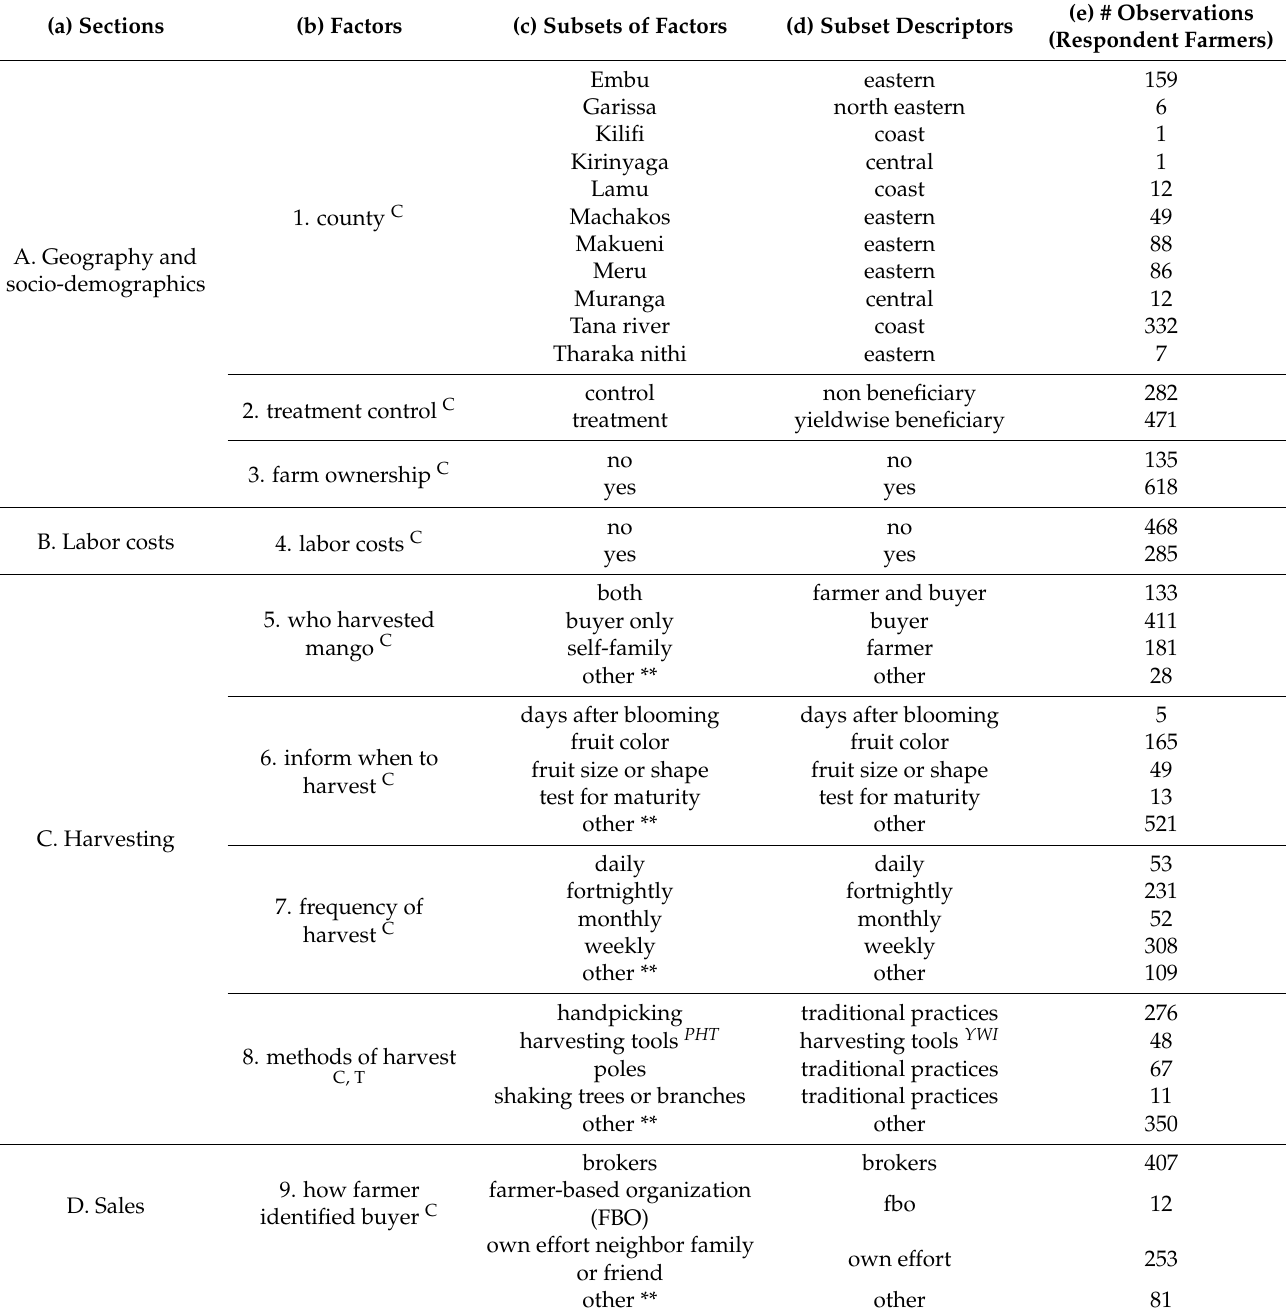
Table 1. A summary of the dataset showing sections, factors, subsets of factors, and respondent farmers: Column (a) lists the nine sections to which each factor belongs. Column (b) lists all 21 factors, including the 19 categorical C , two numerical N , and four containing postharvest technologies T . Column (c) expands each factor into subsets. Subsets with the superscript PHT are identified as postharvest technologies. Subsets with the superscript PRHT are identified as pre-harvest technologies. Numerical factors consist of numerical values estimated by each respondent farmer. Column (d) renames subsets and combines them into fewer categories to facilitate subsequent analysis. Subset descriptors with the superscript YWI are identified as technologies promoted by the YWI. Column (e) indicates the number of respondent farmers belonging to each subset. For each factor, respondent farmers who reported more than one subset were assigned the subset Other